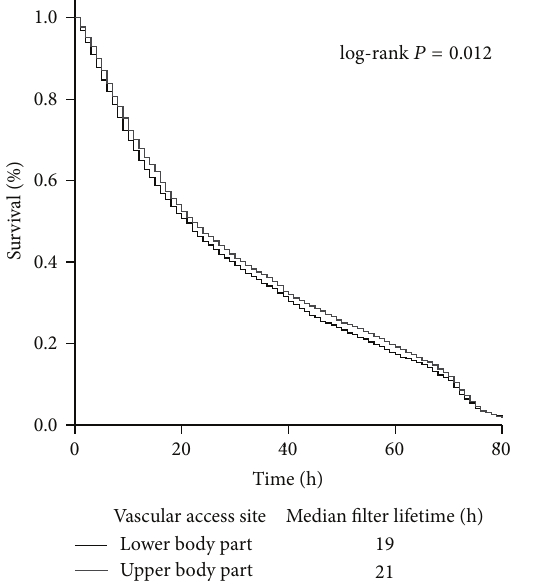
Figure 2: Kaplan-Meier estimates for filter survival during renal replacement therapy dependent on vascular access